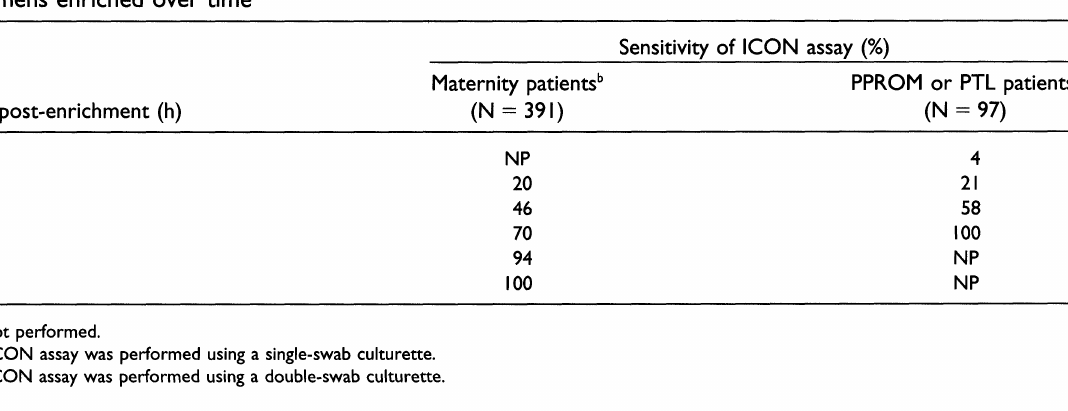
TABLE 2. Effects of patient population and initial inoculum size on sensitivity of ICON assay performed on specimens enriched over